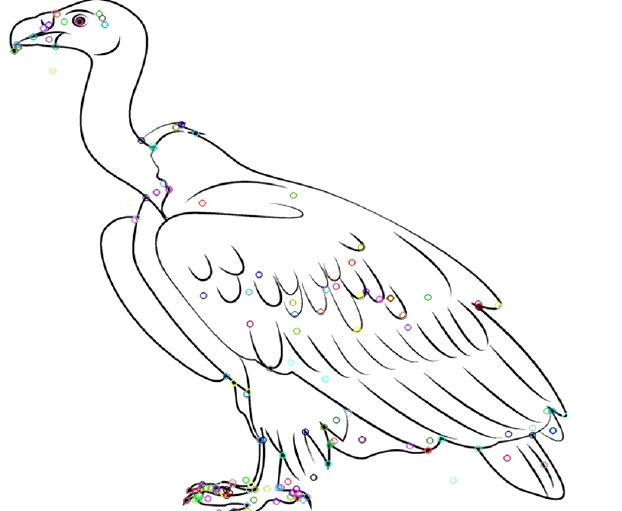
Figure 8. Extracted keypoints using ( a ) SIFT and ( b ) ORB [42].